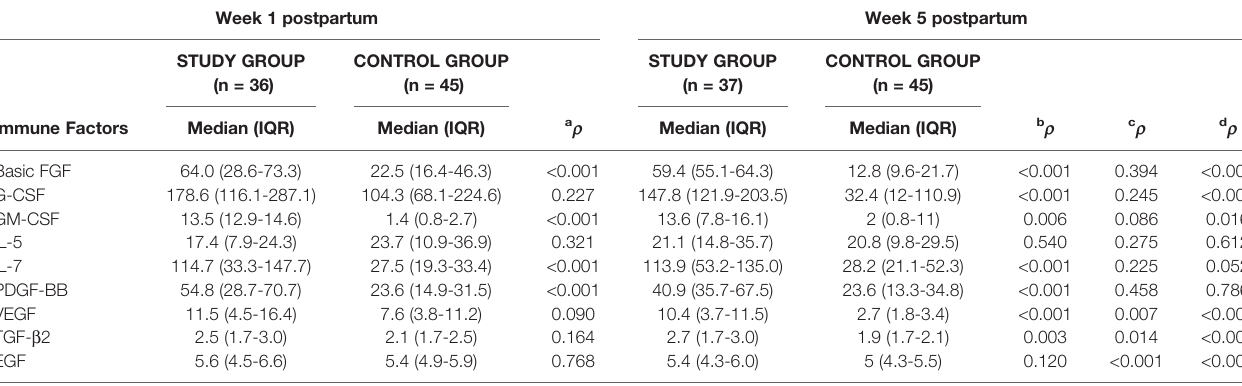
TABLE 3 | Concentration* of growth factors in milk samples from study group and control group women over